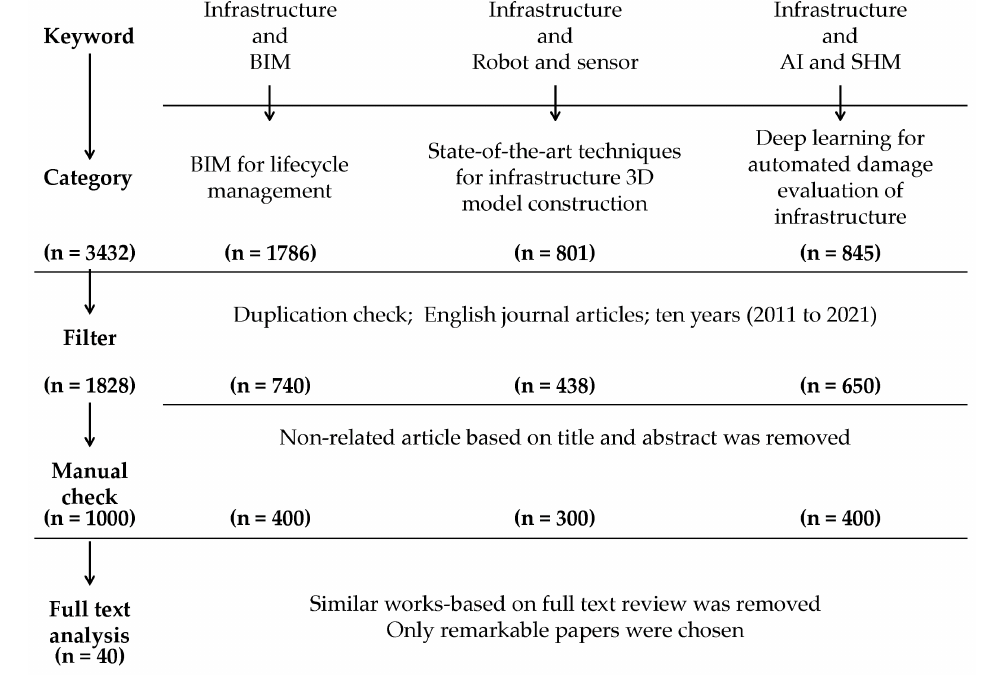
Figure 1. Methodology flow diagram.